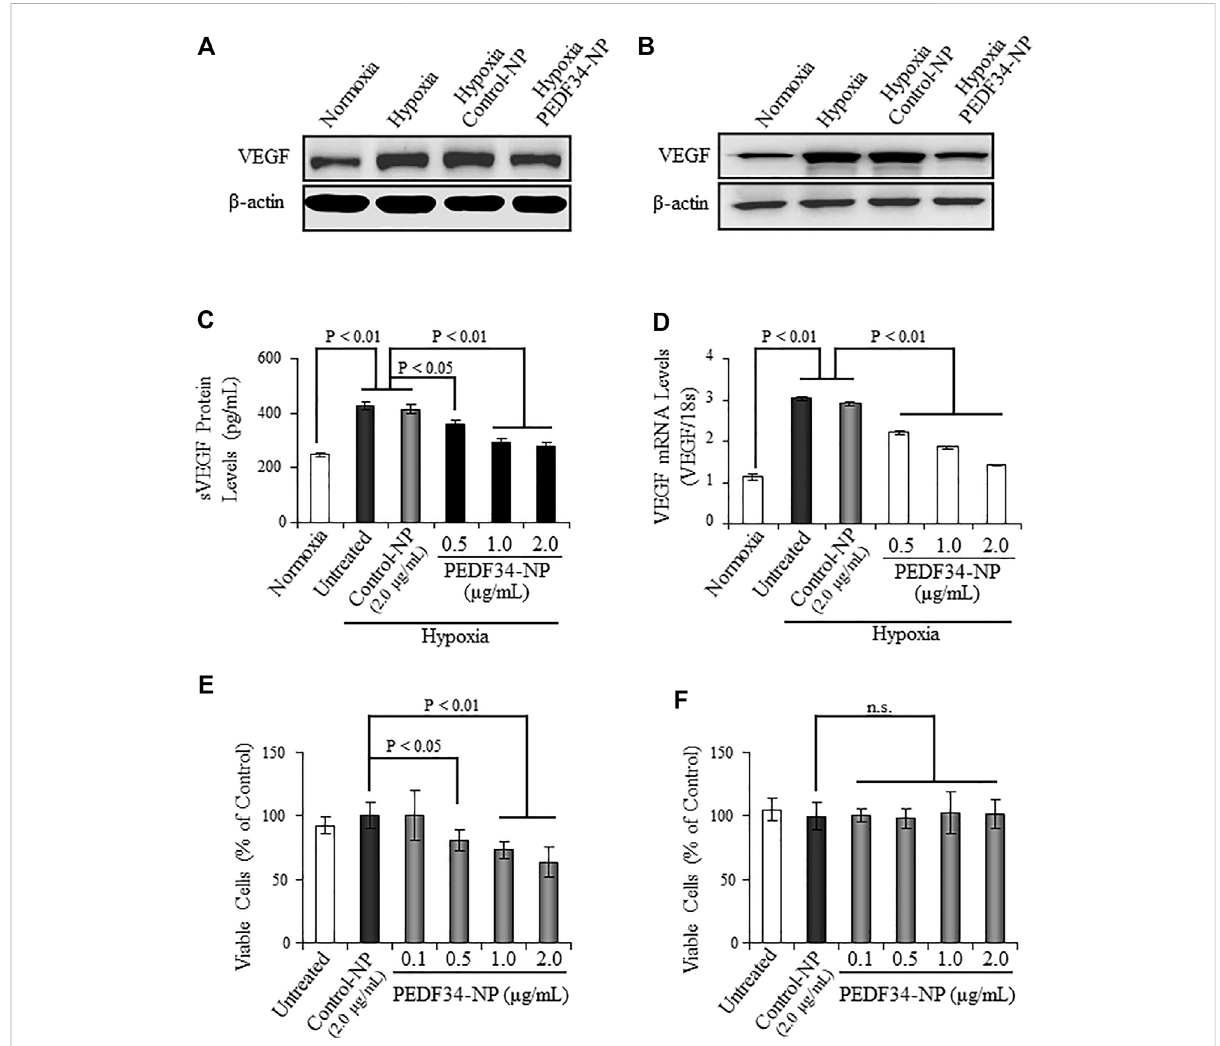
FIGURE 1 Inhibitory effect of PEDF34-NP on VEGF expression induced by hypoxia in ARPE19 cells and BRCEC. (A) ARPE19 cells were grown to 70% con fl uence in media containing 2% FBS and treated with PEDF34-NP at 1 μ g/ml for 16 h under hypoxia (1% oxygen). The same amount of total cellular proteins (30 µg) was applied for Western blot analysis using the antibody speci fi c for VEGF. (B) BRCEC were exposed to hypoxia and PEDF- 34NP for 16 h. VEGF levels in the cells were measured by Western blot analysis. (C) and (D) ARPE19 cells were treated with Control-NP and various concentrations of PEDF34-NP for 24 h under hypoxia. VEGF secreted into the media (sVEGF) was measured by ELISA using an ELISA kit (C) and VEGF mRNA levels were measured by real-time RT-PCR and normalized by 18S rRNA levels (D) . (E) and (F) BRCEC (E) and ARPE19 cells (F) were treated with PEDF34-NP at the indicated concentrations for 24 h. Viable cells were quanti fi ed using the MTT assay. All values are mean ± SD ( n =